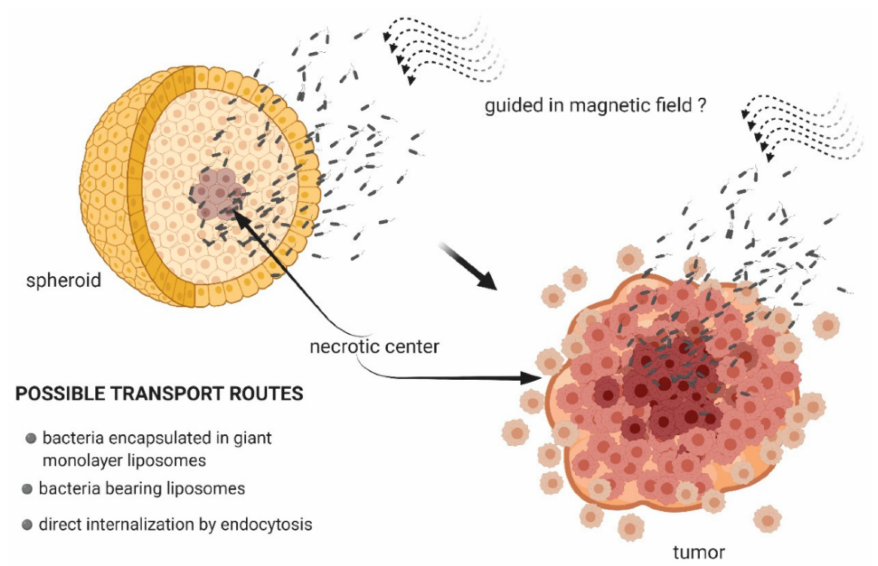
Figure 22. Magnetotactic bacteria as potential drug carriers capable of penetrating the tumor. Reprinted from [242], license CC BY